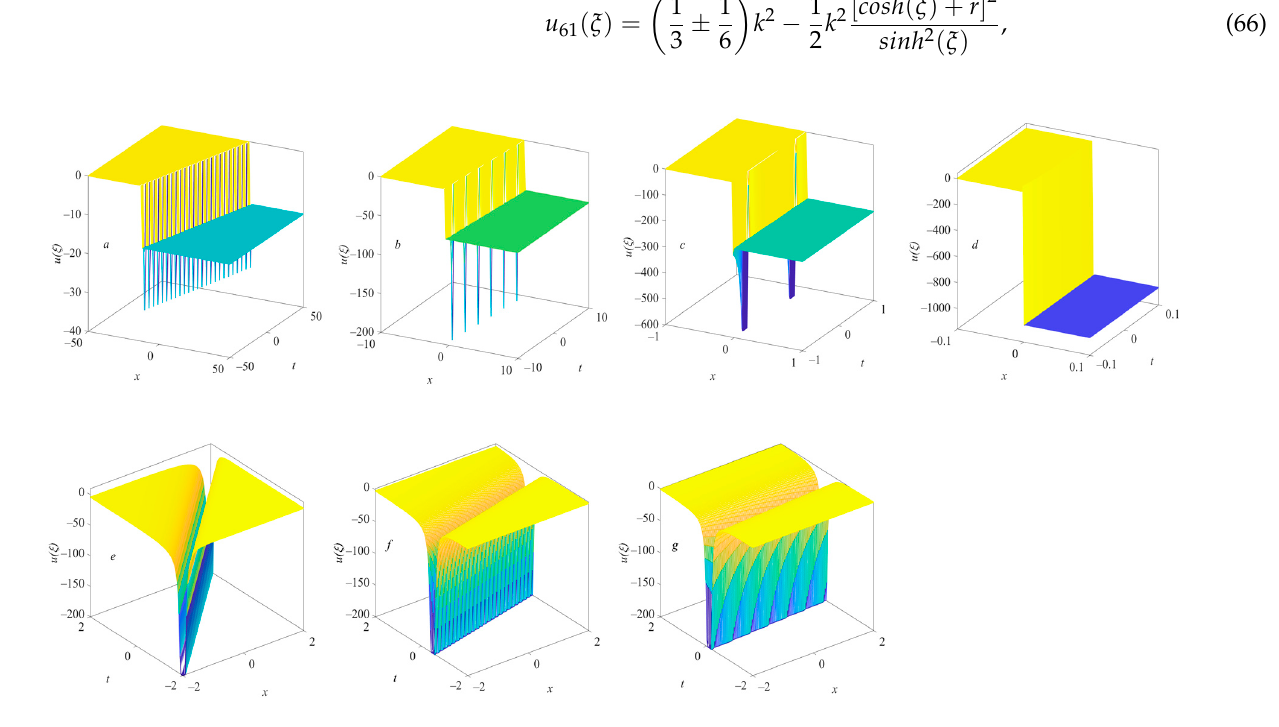
Figure 5. Evolution of solitary waves with n in u 5 n when k = 1, λ = − 1, ν = 1, ε = − 1, r = − 1: ( a ) n = 1, ( b ) n = 2, ( c ) n = 4, ( d ) n = 8, ( e ) n = 1